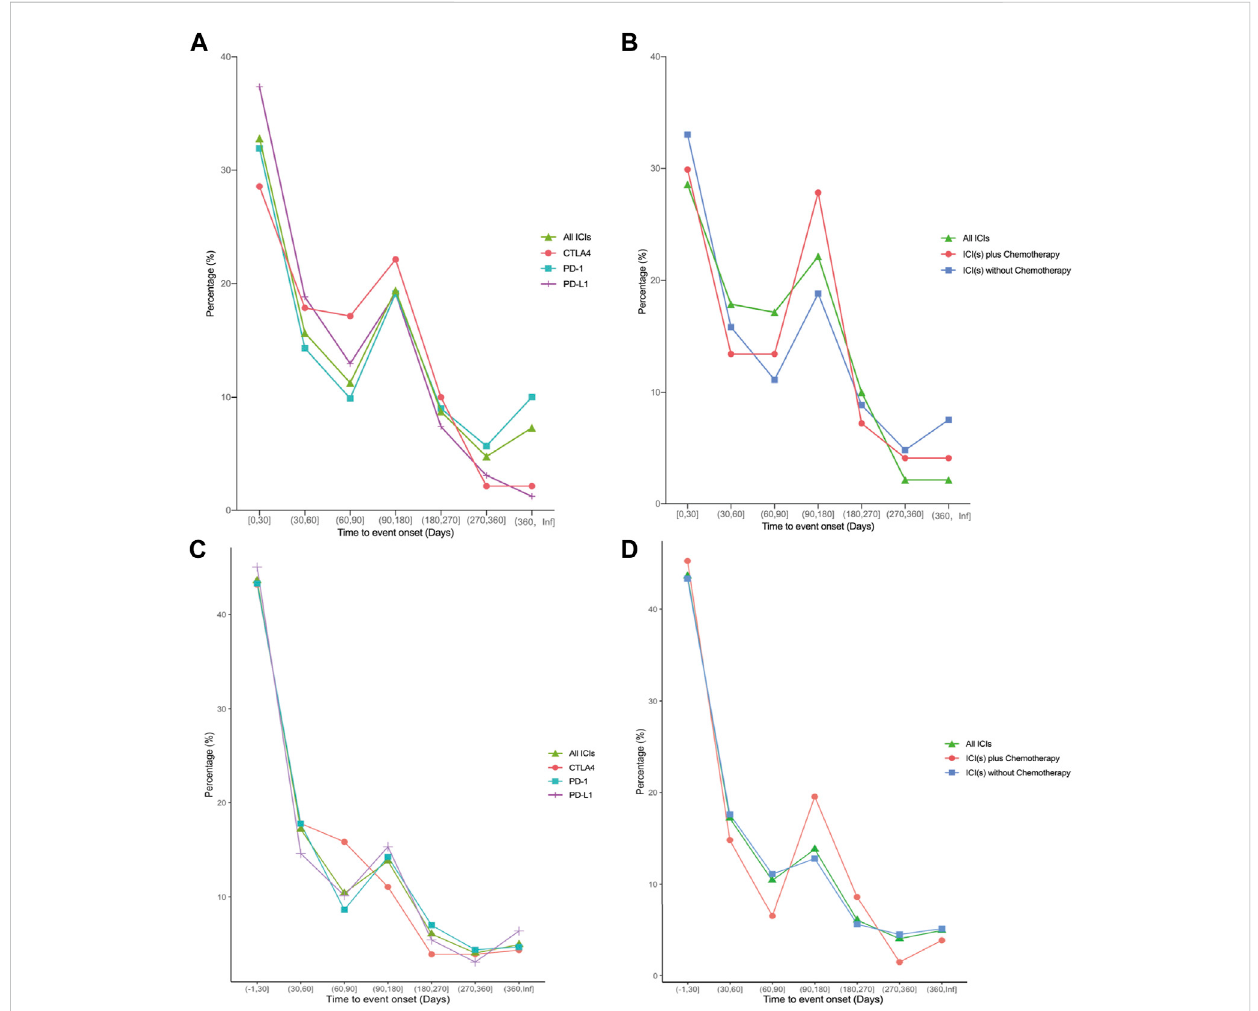
FIGURE 1 Line Plot depicting time-to-onsets of ICI-related pneumonitis after different treatment regimens of ICI(s). (A – B) data from the VigiBase database. (C – D) data from the FAERS database. ICI: immune checkpoint inhibitor; PD-1: programmed cell death receptor 1 inhibitors; PD-L1: programmed cell death ligand 1 inhibitors; CTLA4: cytotoxic T lymphocyte antigen 4